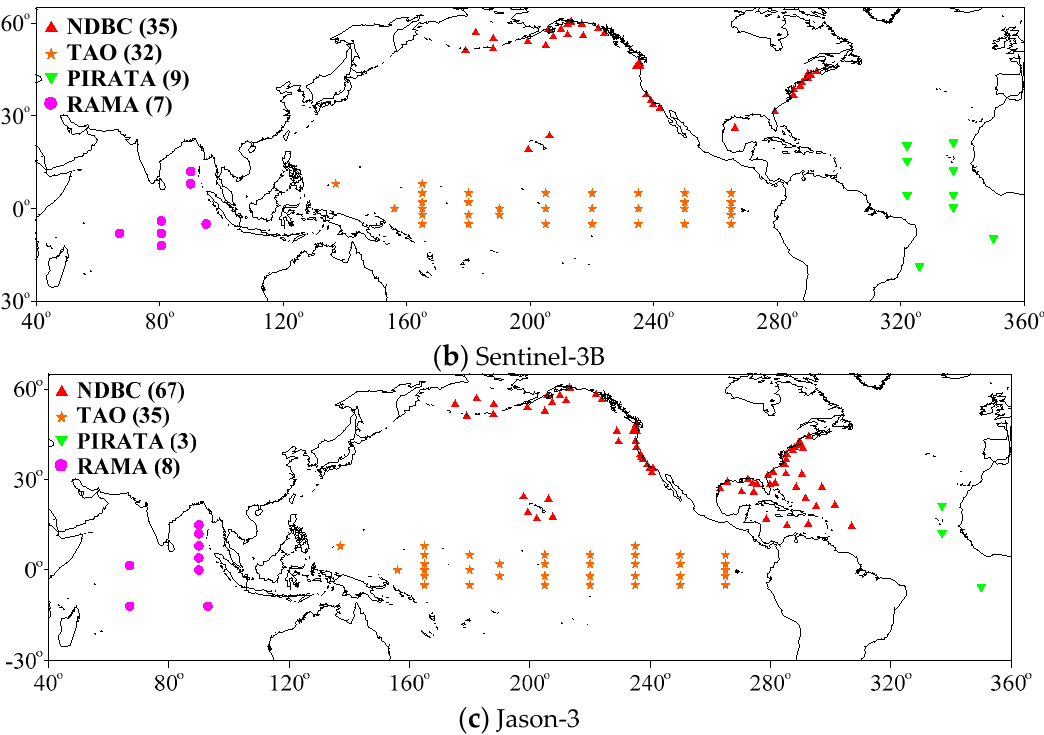
Figure 1. Spatial distributions of the moored buoys matched to ( a ) Sentinel-3A, ( b ) Sentinel-3B and ( c ) Jason-3 for wind speed validation.